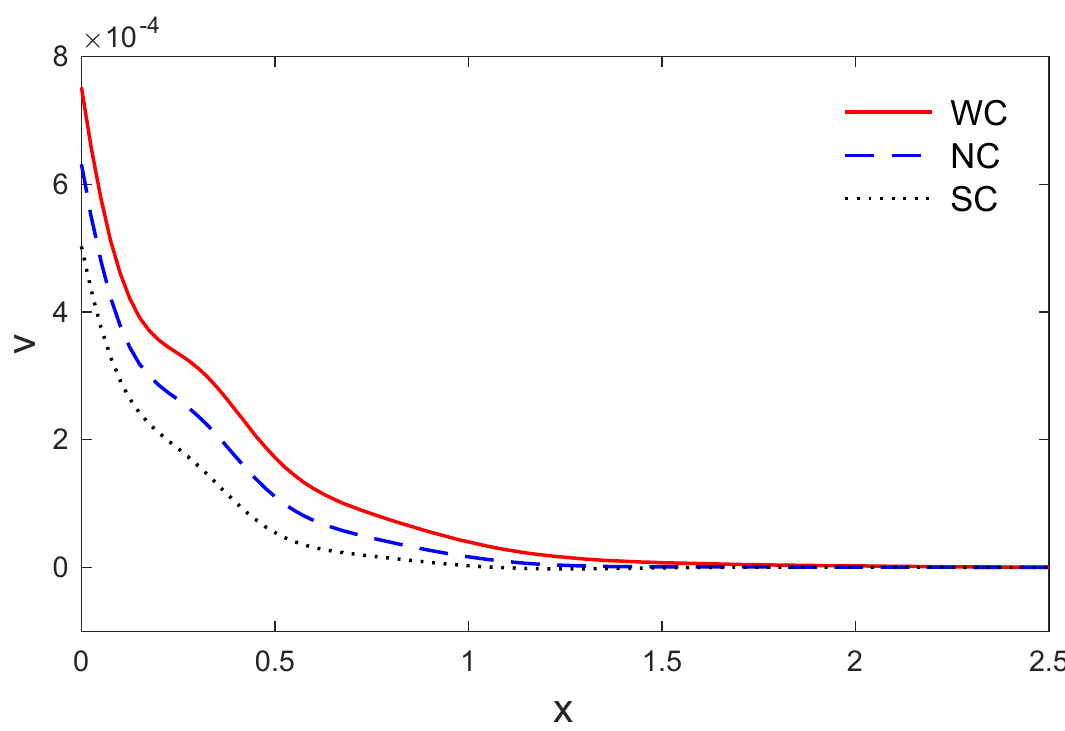
Figure 3. The variations of vertical displacement v via x with y = 0.4 for strong normal and weak conductivities.